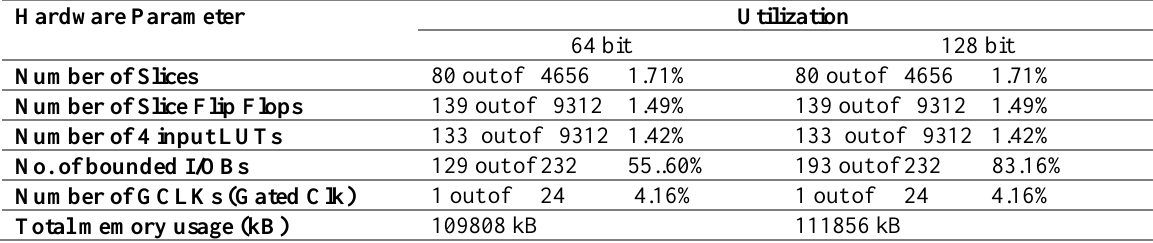
Table 4 Device utilization summary for smart grid TACIT decryption logic Hardware Parameter